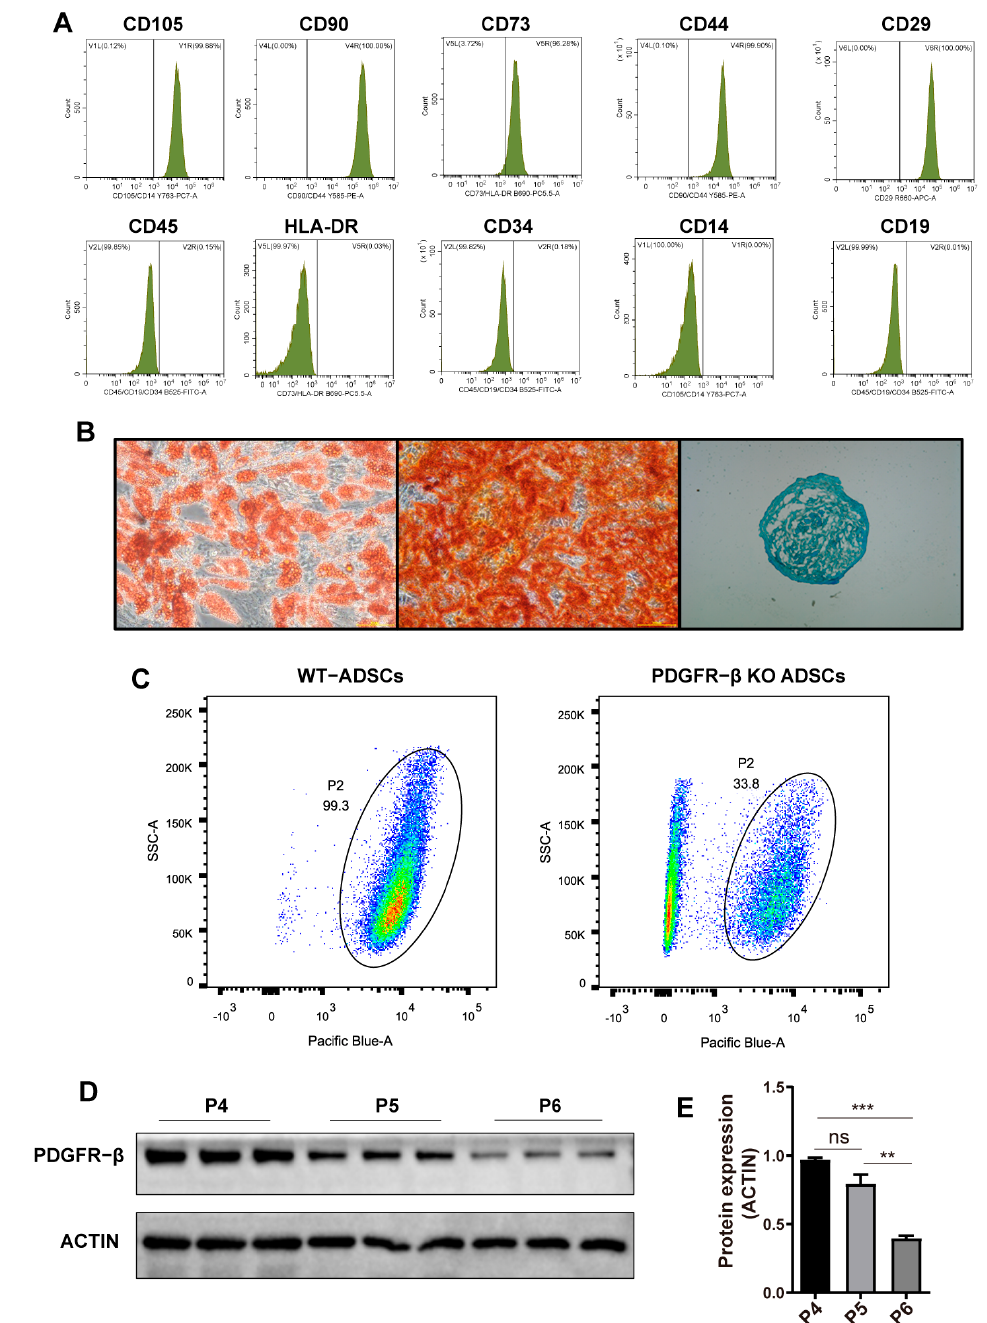
Figure 1. PDGFR– β is dynamically downregulated with ADSC passage. ( A ) Cell surface co– expression of the antigens, CD44, CD73, CD90, and CD105 in MSCs. ( B ) Differentiation potential of MSCs in osteogenic, chrondrogenic, and adipogenic lineages using Alizarin red, Alcian blue, and oil red O staining, respectively. ( C ) Flow cytometry analysis indicating the expression pattern of PDGFR– β in single cell suspensions of ADSCs (CD105–PE, CD90–PE, CD73–CY5.5, CD44-PE, CD29- APC, CD45-FITC, HLA-DR-CY5.5, CD34-FITC, CD14-PE, CD19-FITC). ( D ) PDGFR– β expression and ( E ) levels relative to β –ACTIN in P4–P6 ADSCs ( n = 3). Data are shown as mean ± SD. Independent– sample t test (two–tailed) was used for statistical comparisons between 2 groups; One–way ANOVA followed by Tukey post hoc test was used for statistical comparisons between multiple groups. * * p < 0.01; ** * p <